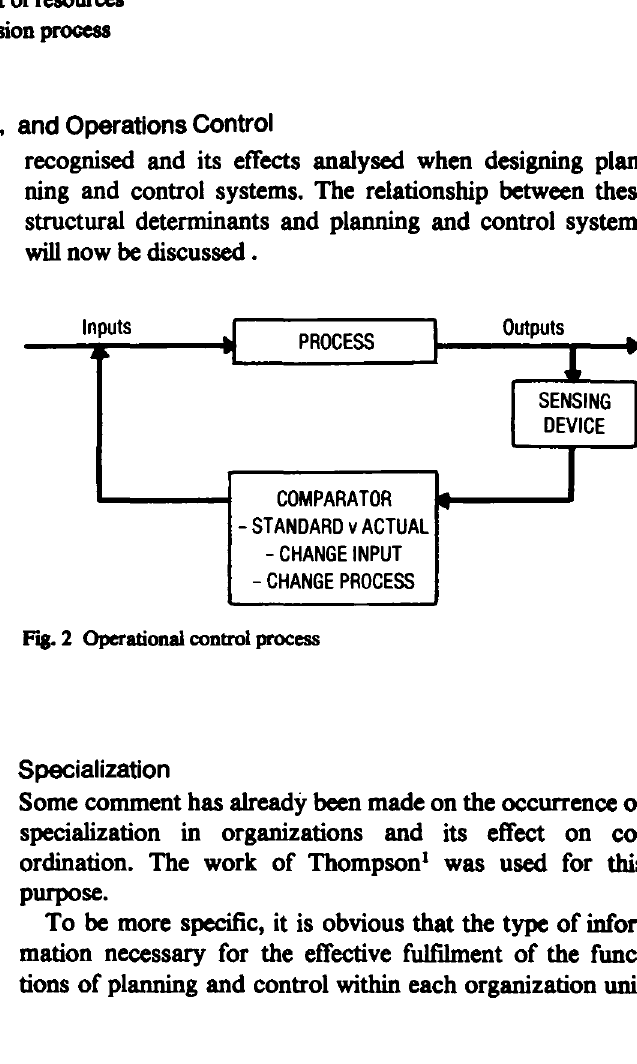
Fig. 2 Operational control